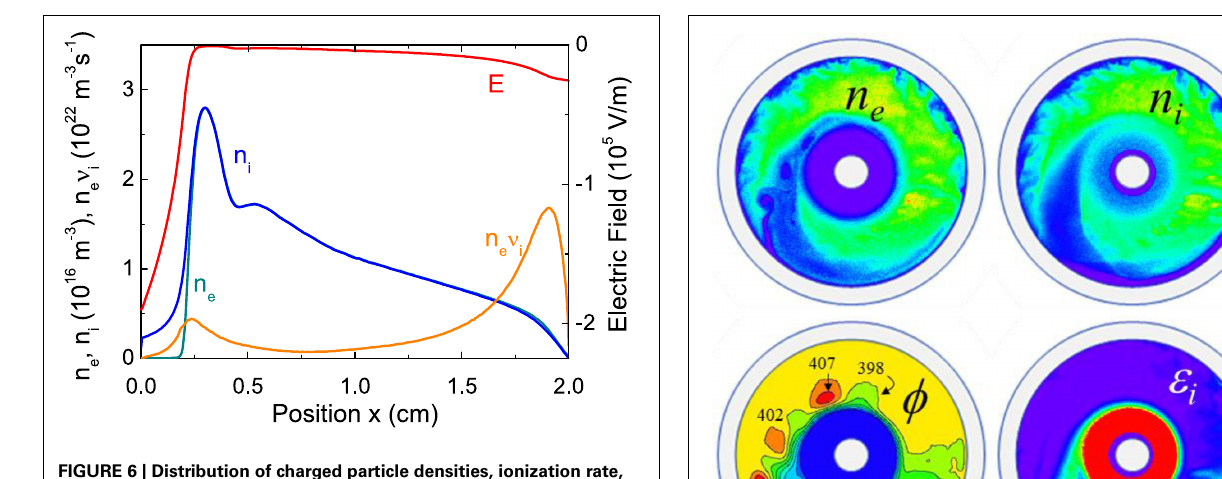
FIGURE 6 | Distribution of charged particle densities, ionization rate, and electric field in a 2cm gap magnetron discharge in argon, 10mTorr, 400V, 30mT, secondary electron emission by ion impact 0.1. The cathode is at x = 0.